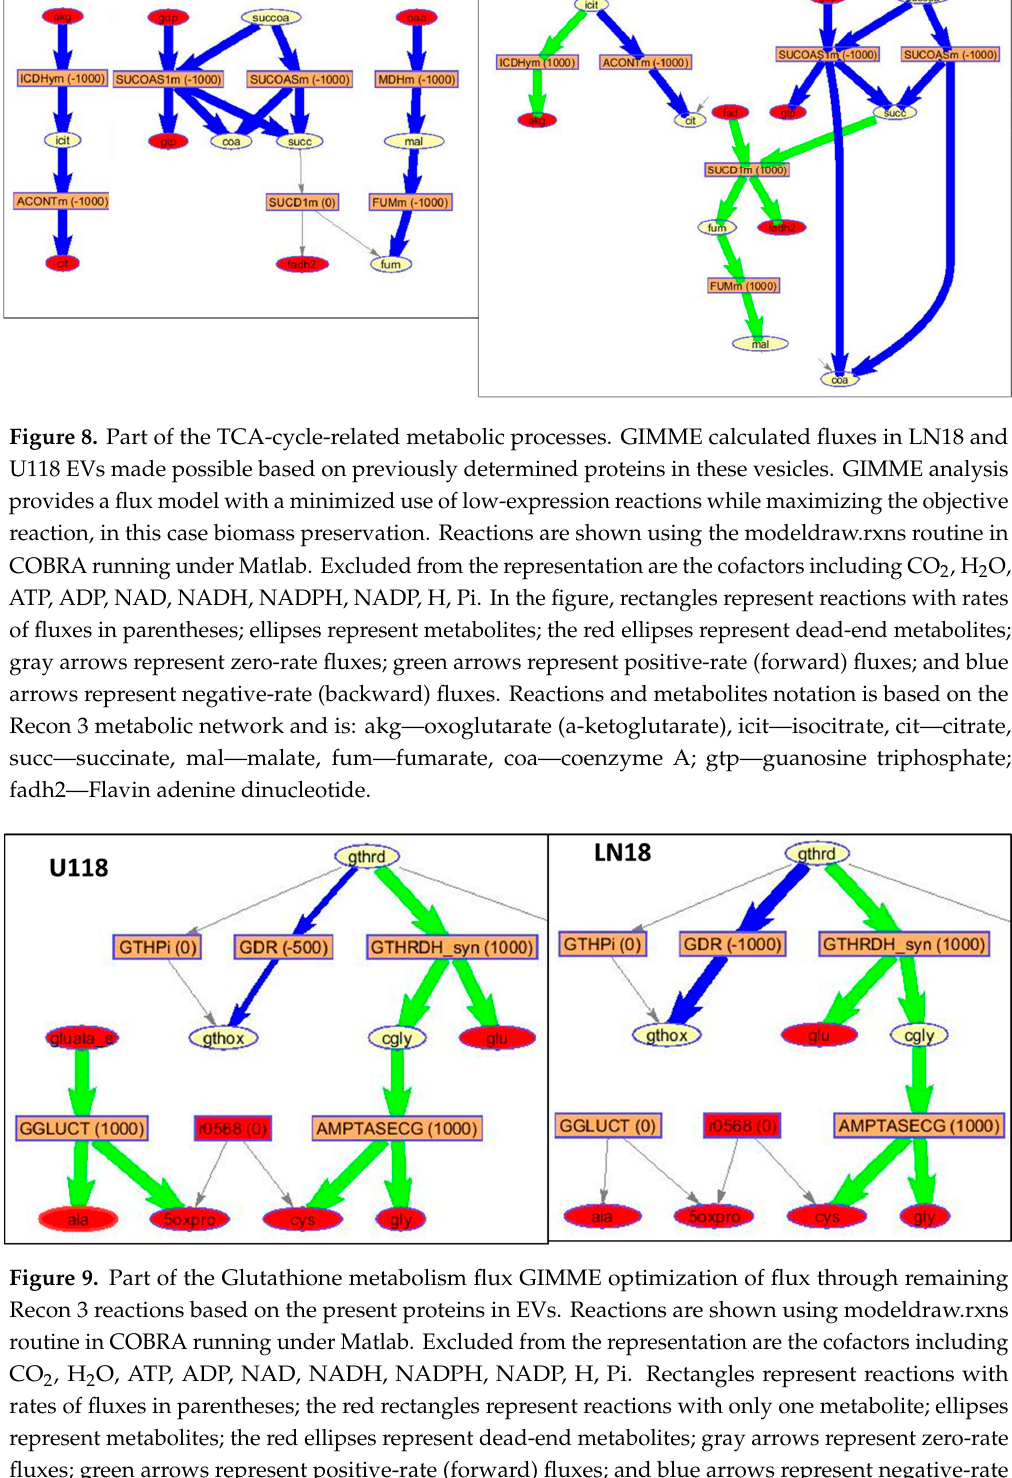
Figure 9. Part of the Glutathione metabolism flux GIMME optimization of flux through remaining Recon 3 reactions based on the present proteins in EVs. Reactions are shown using modeldraw.rxns routine in COBRA running under Matlab. Excluded from the representation are the cofactors including CO 2 , H 2 O, ATP, ADP, NAD, NADH, NADPH, NADP, H, Pi. Rectangles represent reactions with rates of fluxes in parentheses; the red rectangles represent reactions with only one metabolite; ellipses represent metabolites; the red ellipses represent dead-end metabolites; gray arrows represent zero-rate fluxes; green arrows represent positive-rate (forward) fluxes; and blue arrows represent negative-rate (backward) fluxes. Reactions and metabolites notation is based on the Recon 3 metabolic network and is: gthrd—reduced glutathione; gthox—oxidized glutathione; glu—glutamine; gly—glycine; ala—alanine; cys—